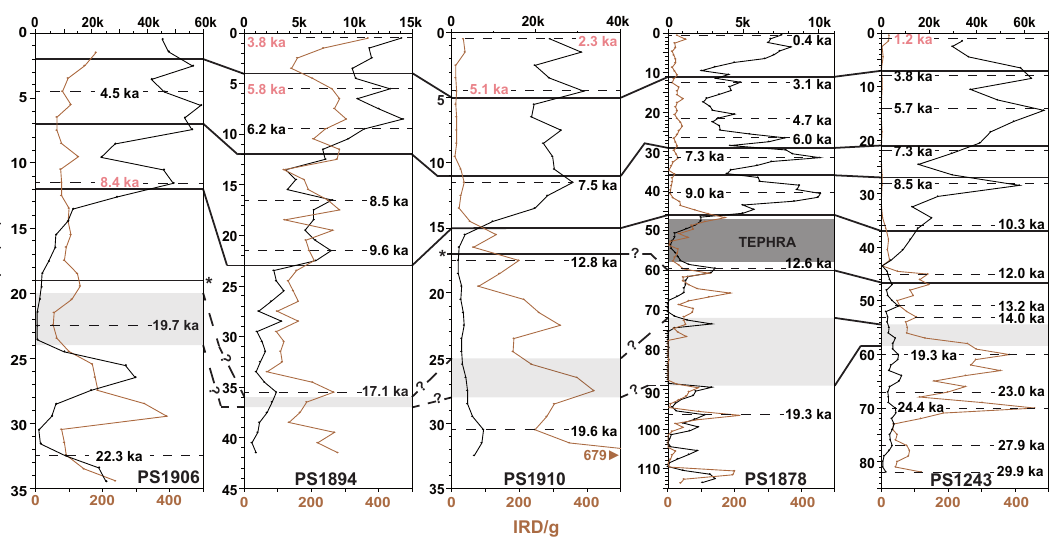
Fig. 3. Planktic foraminifera and IRD abundance (per 1g dry sediment) of cores used in this study and core PS1243. Correlation and ages as in Fig. 2.